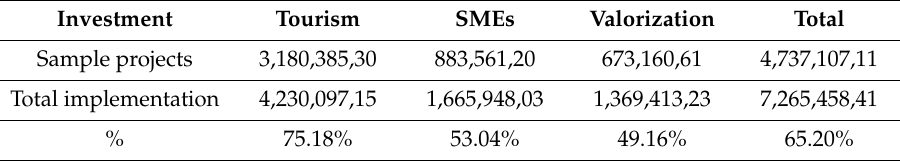
Table 1. Representativeness of the selected sample according to the investment.